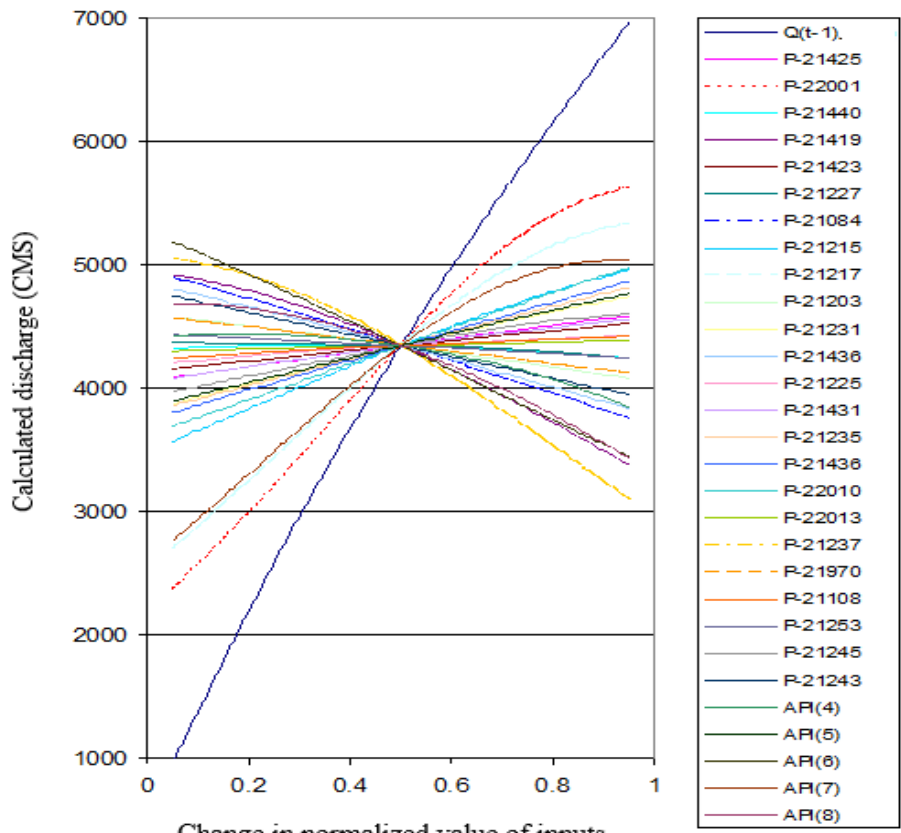
Fig. 5 Sensitivity analysis for Model 5 with initial 29 input